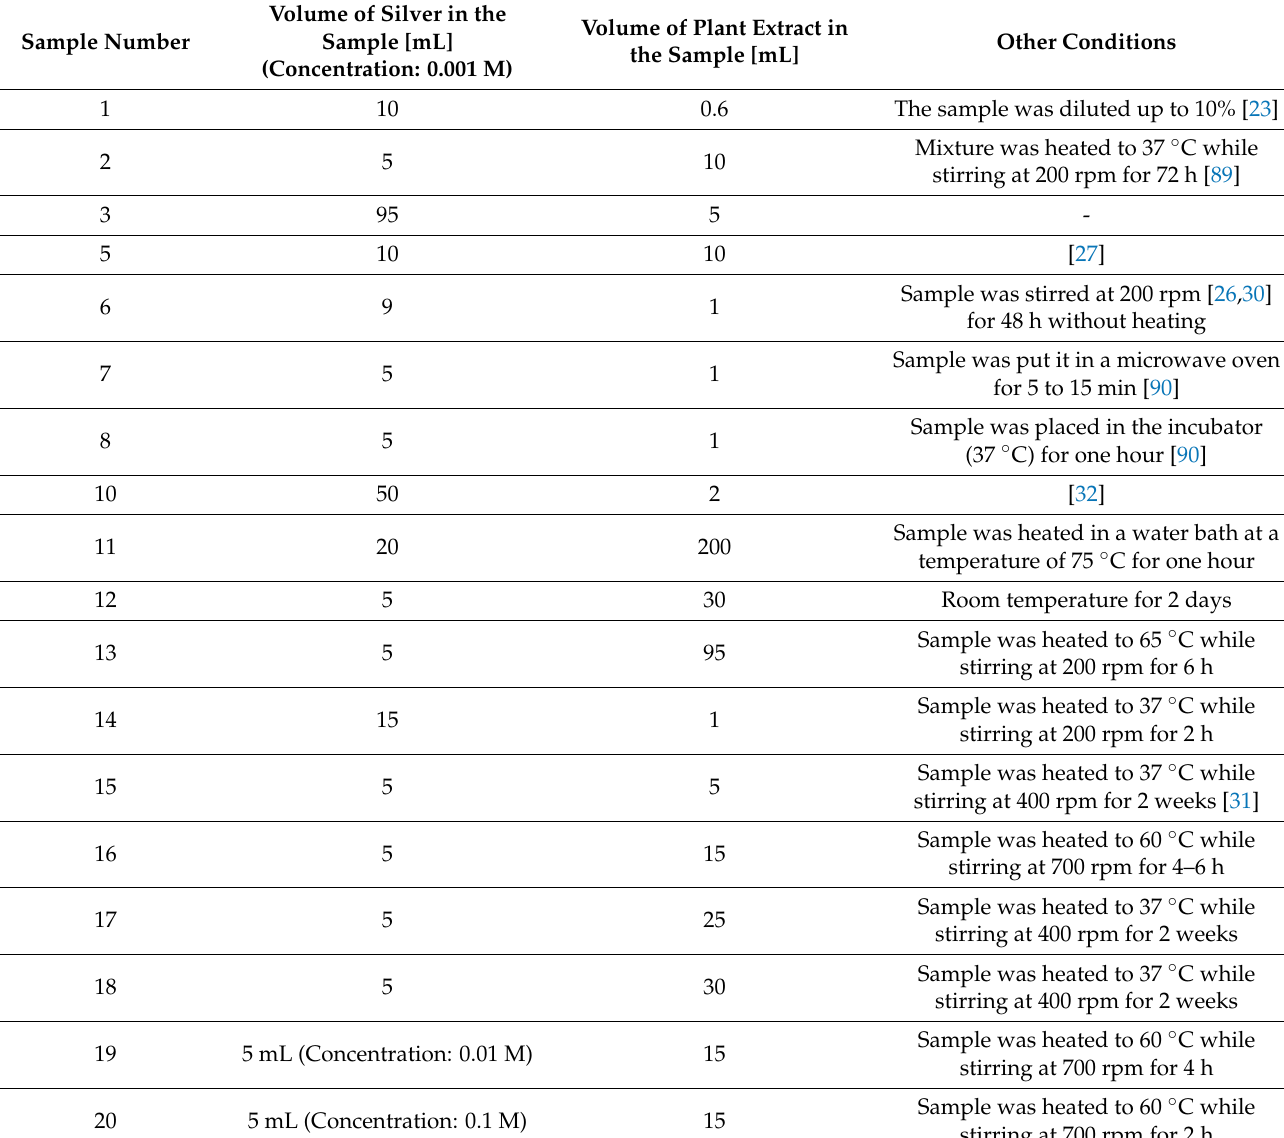
Table 1. Protocols used for AgNPs preparation, more details can be found in the supplementary